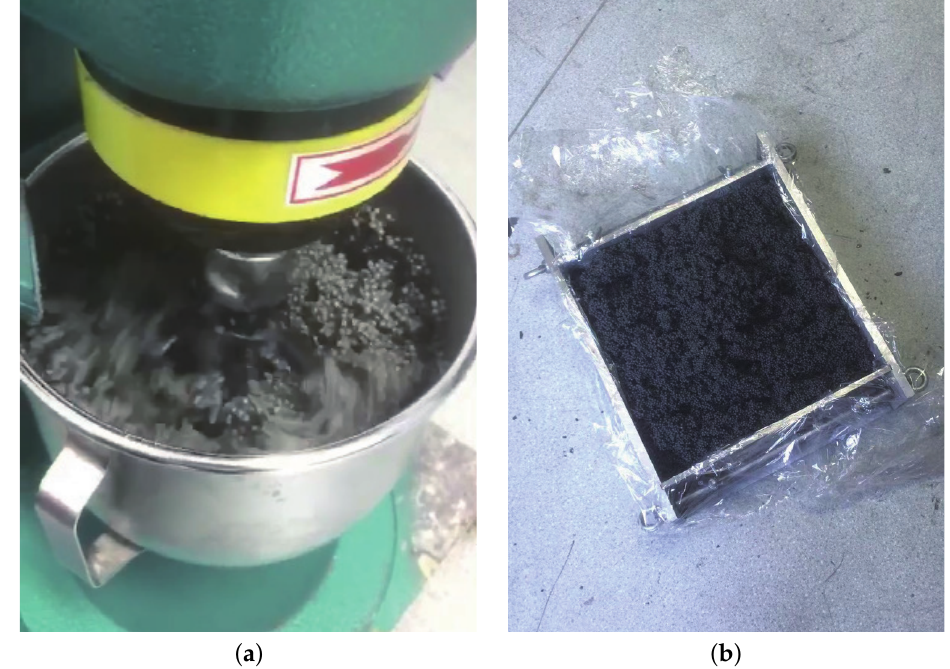
Figure 11. Preparation of the GCIB samples: ( a ) mixing mixture; ( b ) mixture molding.